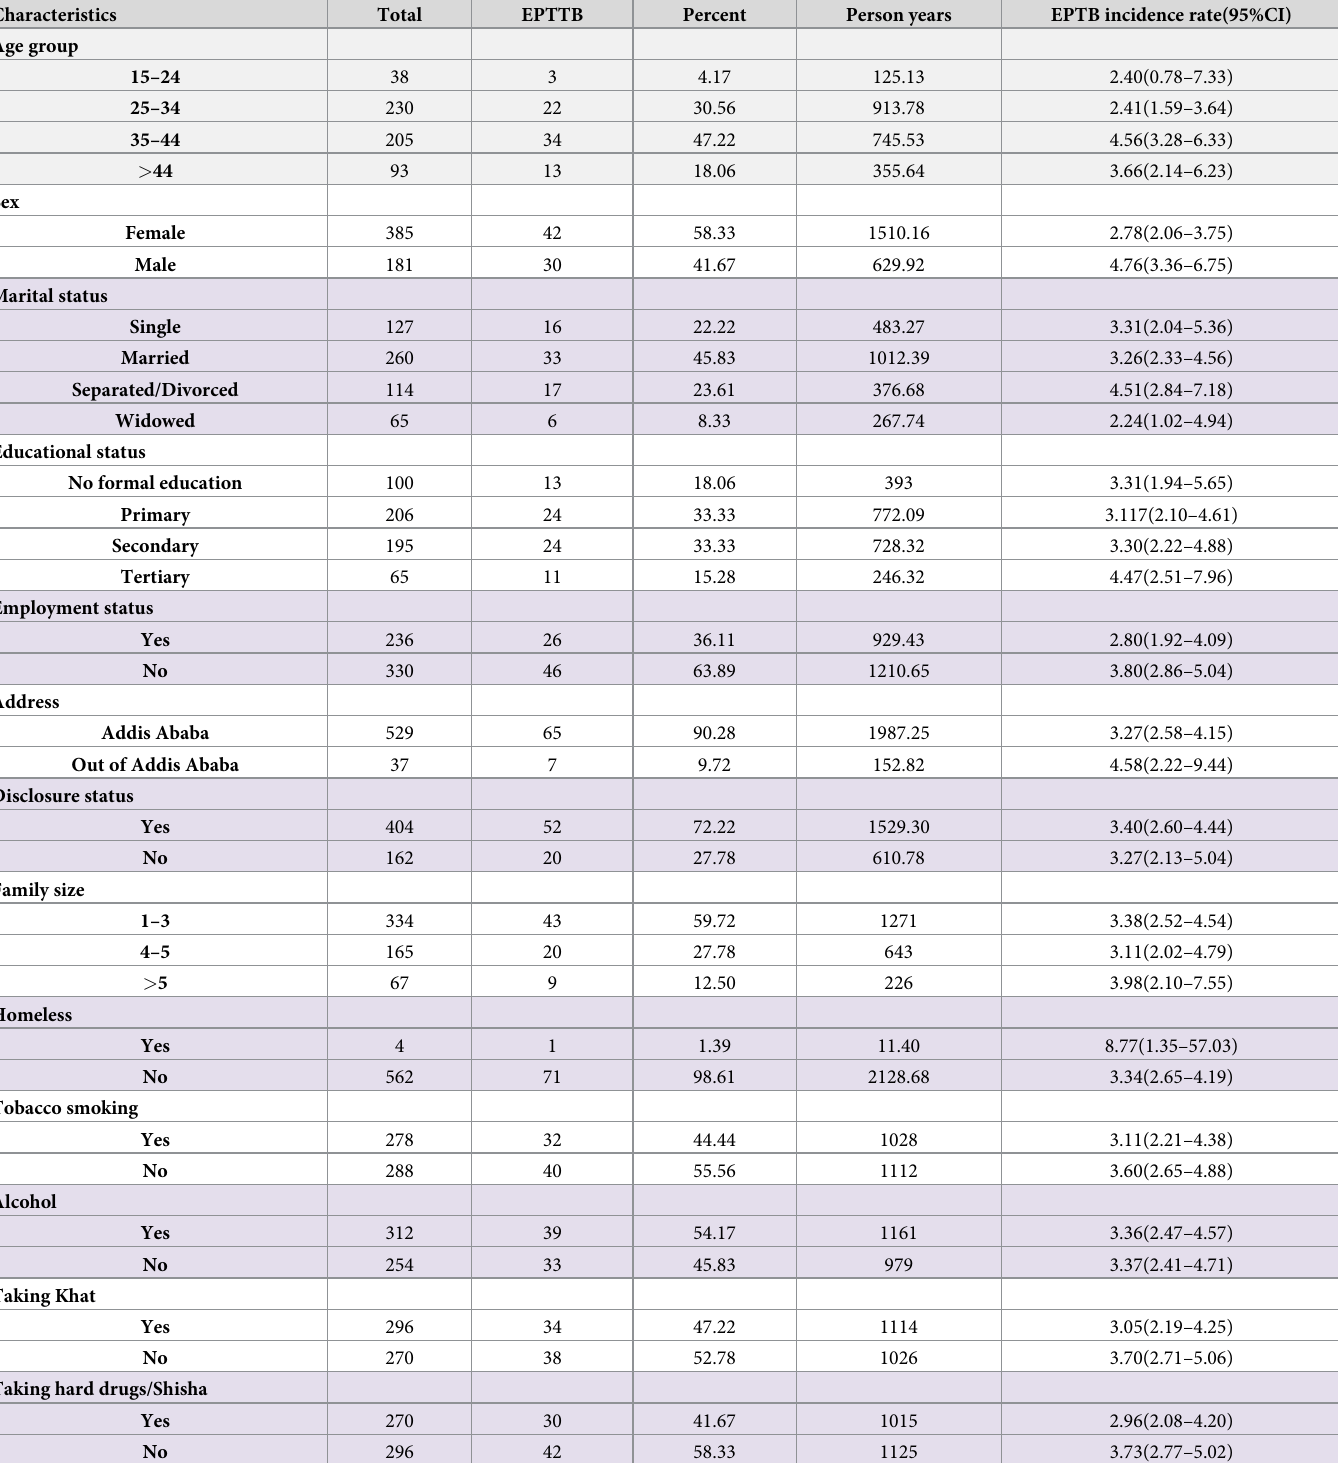
Table 3. Extrapulmonary tuberculosis incidence density among HIV positive patients in Addis Ababa, Ethiopia, from 01 January 2013 up to 31 December 2018 (n = 566).